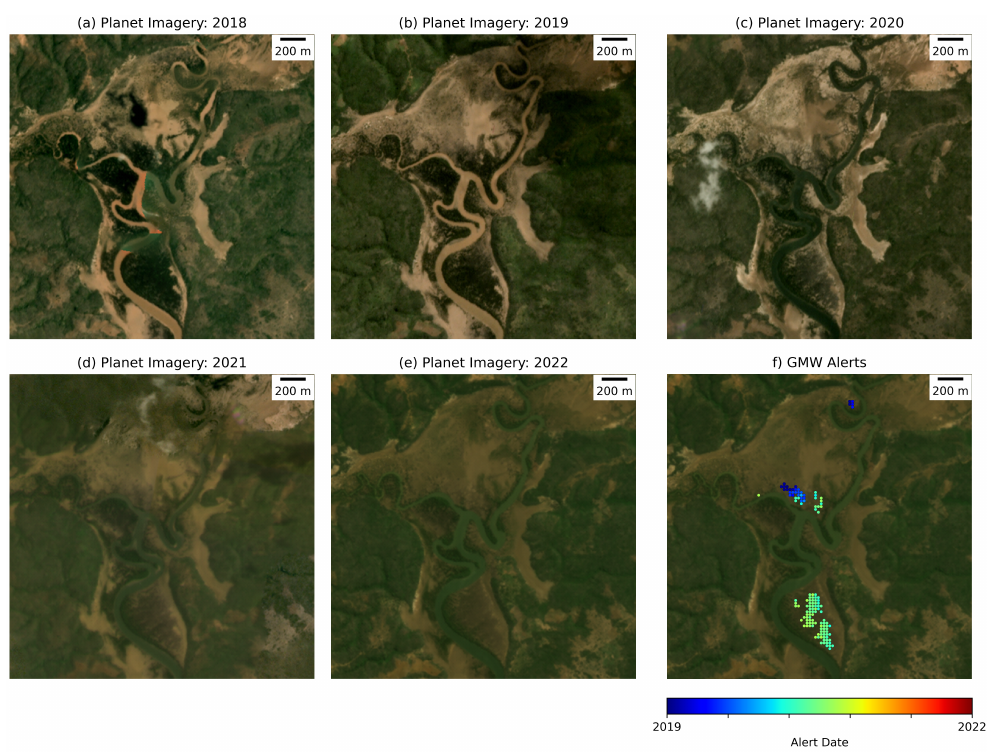
Figure 15. A case study from Kenya where the alerts identified mangroves being lost due to charcoal production. ( a ) Illustrates the planet imagery before the mangrove loss, ( b – e ) mangroves lost over the period and ( f ) the GMW Mangrove Loss Alerts identified over the period. (Image courtesy: Planet Labs/NICFI).